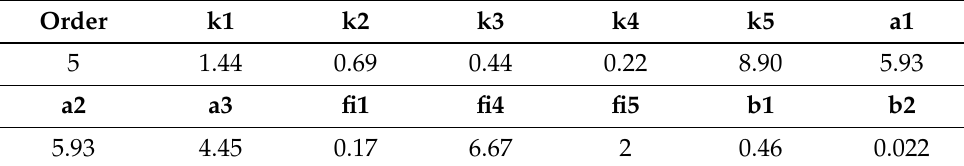
Table 2. Modulator coefficients.